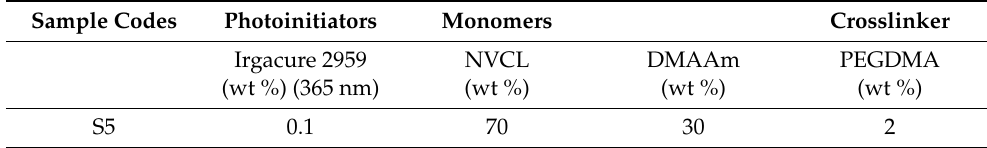
Table 1. The formulation of the samples used in this study.